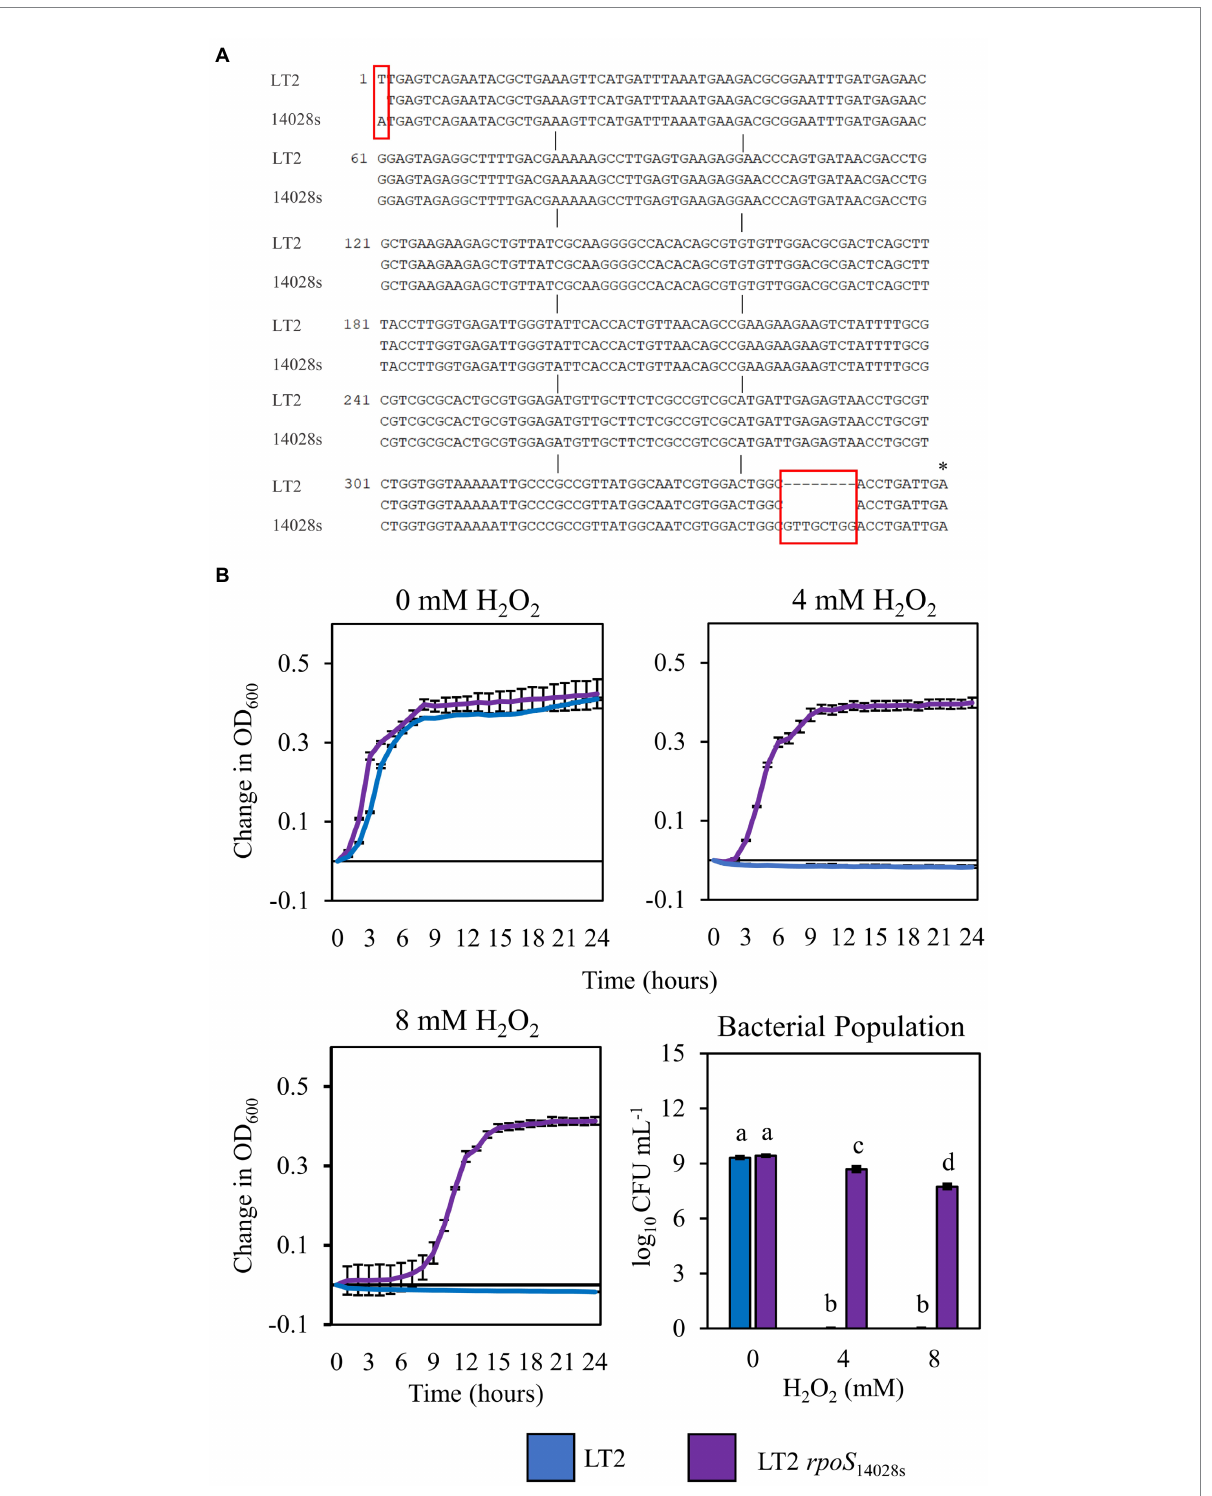
FIGURE 4 Restoration of the rpoS ORF of S. enterica LT2 increases tolerance to H 2 O 2 . (A) Nucleotide sequence alignment of the first 362 bp of the rpoS gene in S. enterica strains LT2 and 14028s. Red boxes indicate nucleotide differences between strains. Asterisk indicates premature stop codon. (B) Growth curves of S. enterica LT2 (blue) and LT2 rpoS 14028s (purple) in LB with 0, 4, 8 mm H 2 O 2 amended. Cultures were aliquoted into 4 replicate wells, incubated at 22 ° C, and the OD 600 was recorded every hour. Growth was measured as the average change in measured OD 600 with standard deviation error bars ( n = 4 wells). Bacterial populations were measured as log colony forming units per mL after 2 h treatment with H 2 O 2 . Data are means ± SD ( n = 3). Different letters indicate significant differences (2-way ANOVA for each strain at p < 0.05). Two independent experiments were conducted with similar